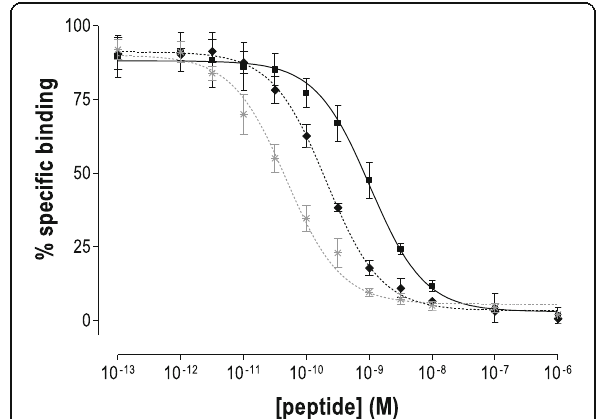
Fig. 2 Displacement of [ 125 I-Tyr 25 ]LTT-SS28 from hSST 2 binding sites in HEK293-hSST 2 cell membranes by increasing concentrations of the following: square, [ nat Ga]Ga-DATA-TOC (IC 50 = 1.03 ± 0.08 nM, n = 3); diamond, [ nat Ga]Ga-DOTA-TOC (IC 50 = 0.21 ± 0.01 nM, n = 2);